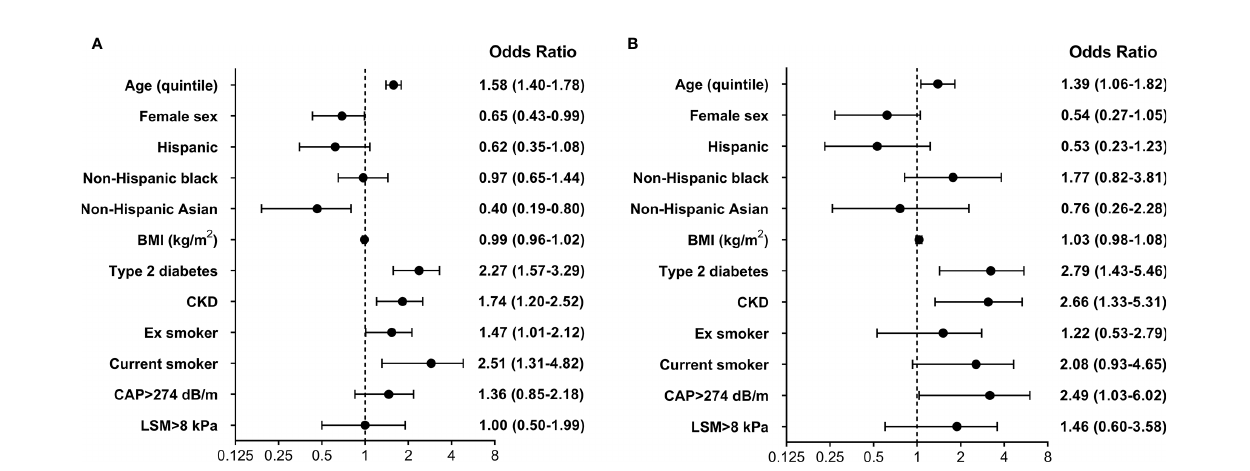
FIGURE 2 | Multivariable logistic regression model evaluating the effect of several predictors on the presence of (A) cardiovascular disease (CVD) and (B) heart failure (HF). Reference categories for cigarette smoke were never smoker, while the reference category for race-ethnicity was non-Hispanic white. BMI, body mass index; CAP, controlled attenuation parameter; LSM, liver stiffness measurement; CKD, chronic kidney